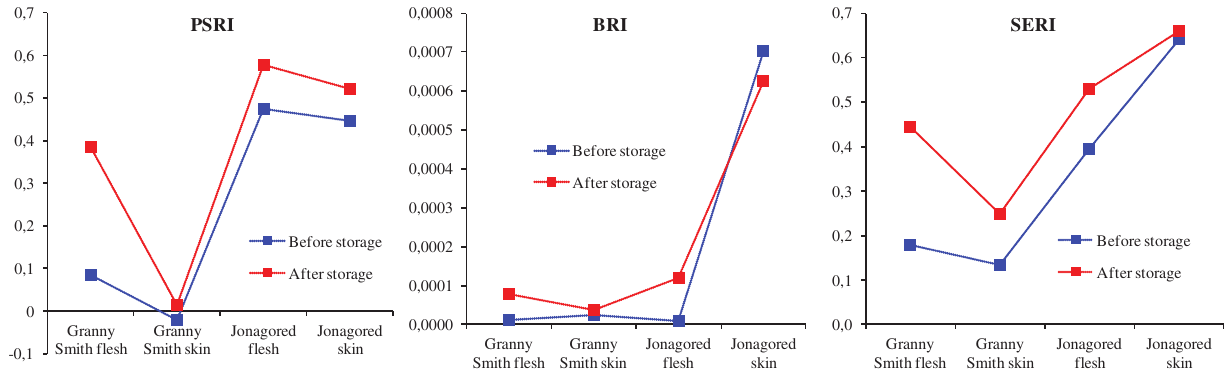
Figure 2. The created indices to detecting the effect of chilling